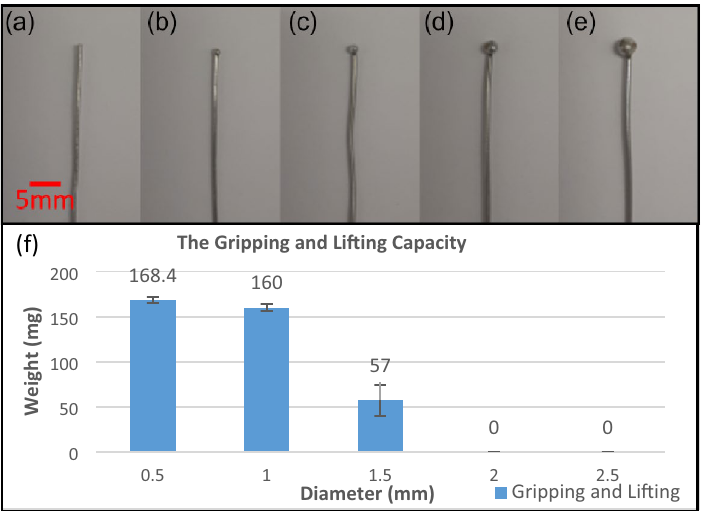
Figure 12. Balls with various sizes and adjustable weights, and weightlifting ability. The size of the balls is adjusted by melting the tip of the solder wire. ( a ) 0.5 mm, ( b ) 1 mm, ( c ) 1.5 mm, ( d ) 2 mm, ( e ) 2.5 mm. ( f ) The maximum weight that a developed microgripper can lift for a ball with various diameters can be seen here. The microgripper cannot grip and lift a ball of 2 mm in diameter or